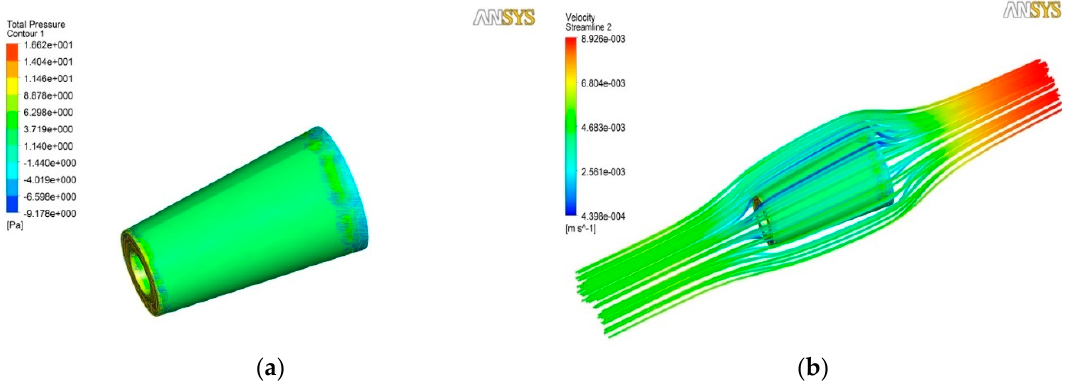
Figure 3. Results calculated by Fluent numerical calculation software. The length of the micromotor is 10 μ m. The semi-cone angle is 5°, the larger radius is 5 μ m and the inlet velocity of the fluid is 5 mm/s. ( a ) The pressure distribution on the surface of the micromotor; ( b ) the velocity distribution of the flow field around the micromotor.